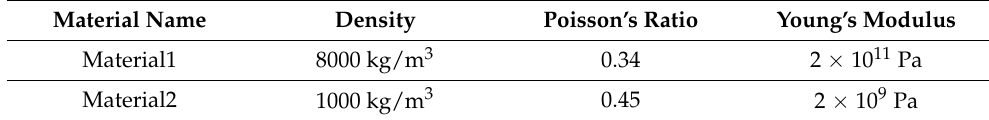
Table 2. Properties of